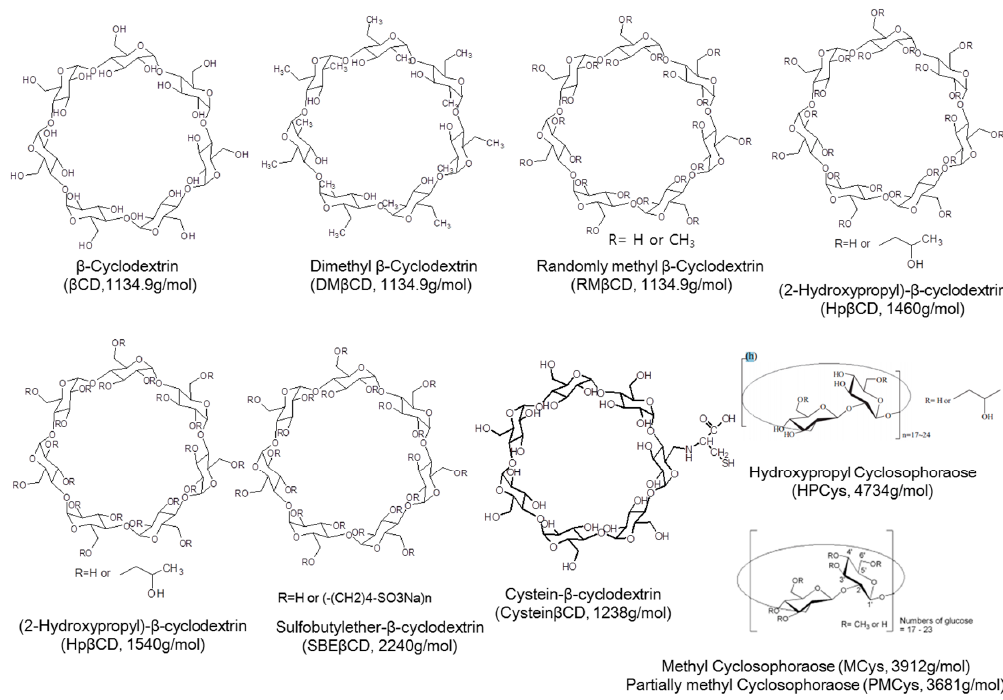
Figure 2. A variety of host molecules.